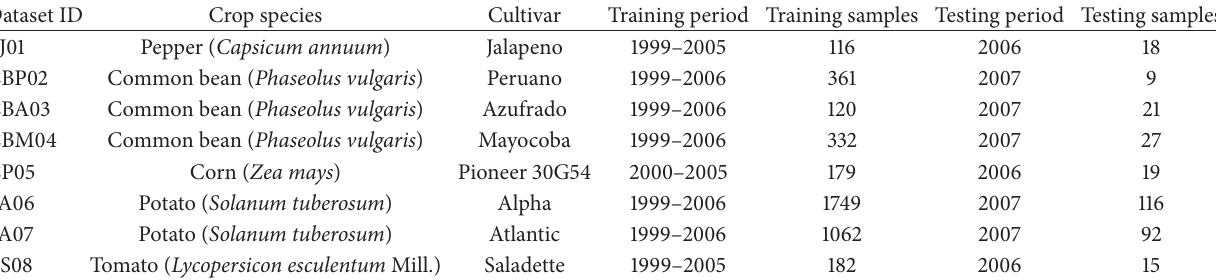
Table 2: Testing and training samples distribution per crop